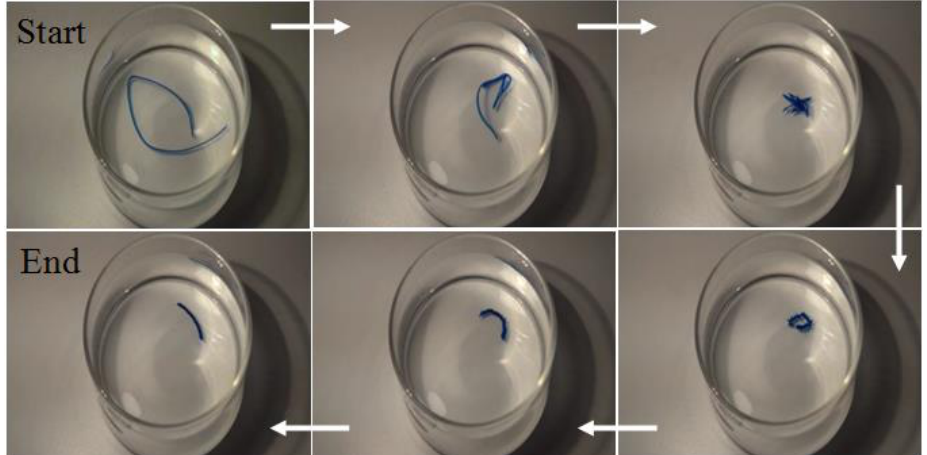
Figure 1. The forced elasticity driven by diffusion of water into a DN hydrogel dried in its extended state. “Start” denotes when the dry extended hydrogel is placed back into water. The arrows show the temporal progression of the shape of the hydrogel, and “End” denotes the point where a new regime of diffusion starts towards a new equilibrium state. Times associated with each image in the direction of arrows are t = 0, 7, 13, 45, 51 and 56